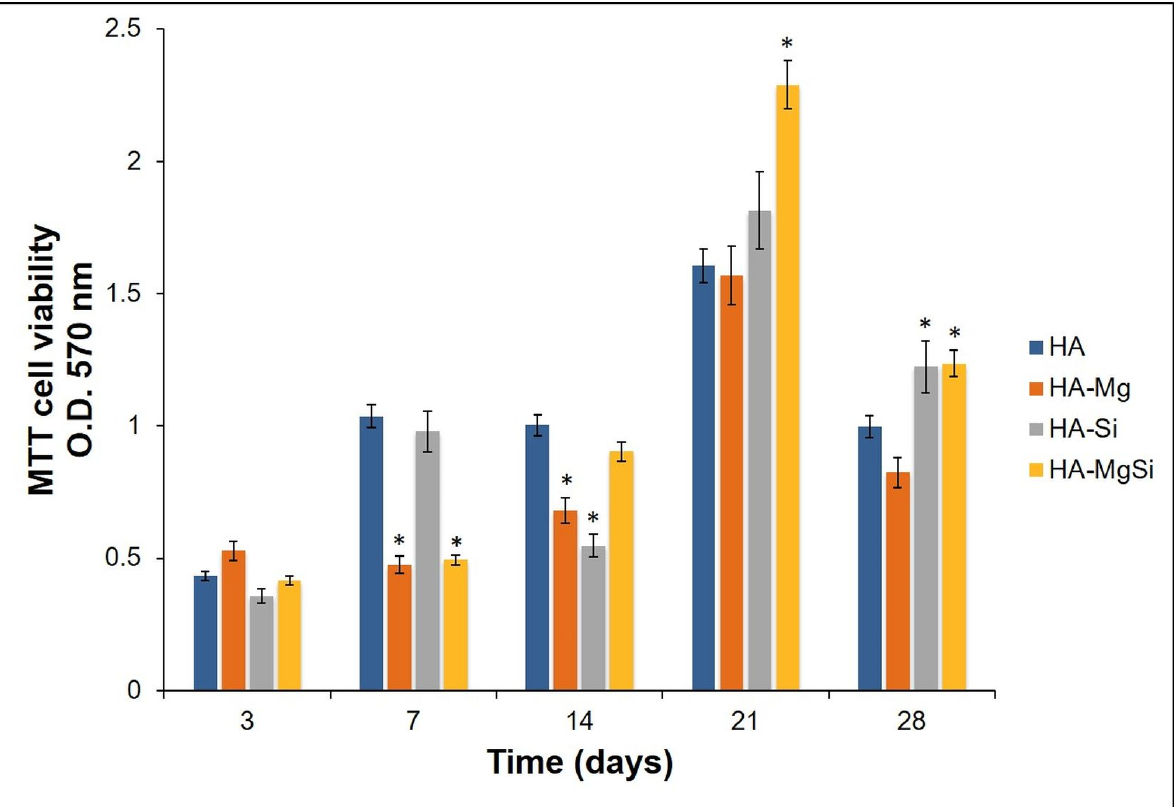
Figure 8. Cell proliferation. BMSC viability was assessed by MTT assay after 3, 7, 14, 21 and 28 days of cell seeding. Data represent the means ± SD of duplicate measurements from three independent experiments. HA scaffold was used as control. * p < 0.05.